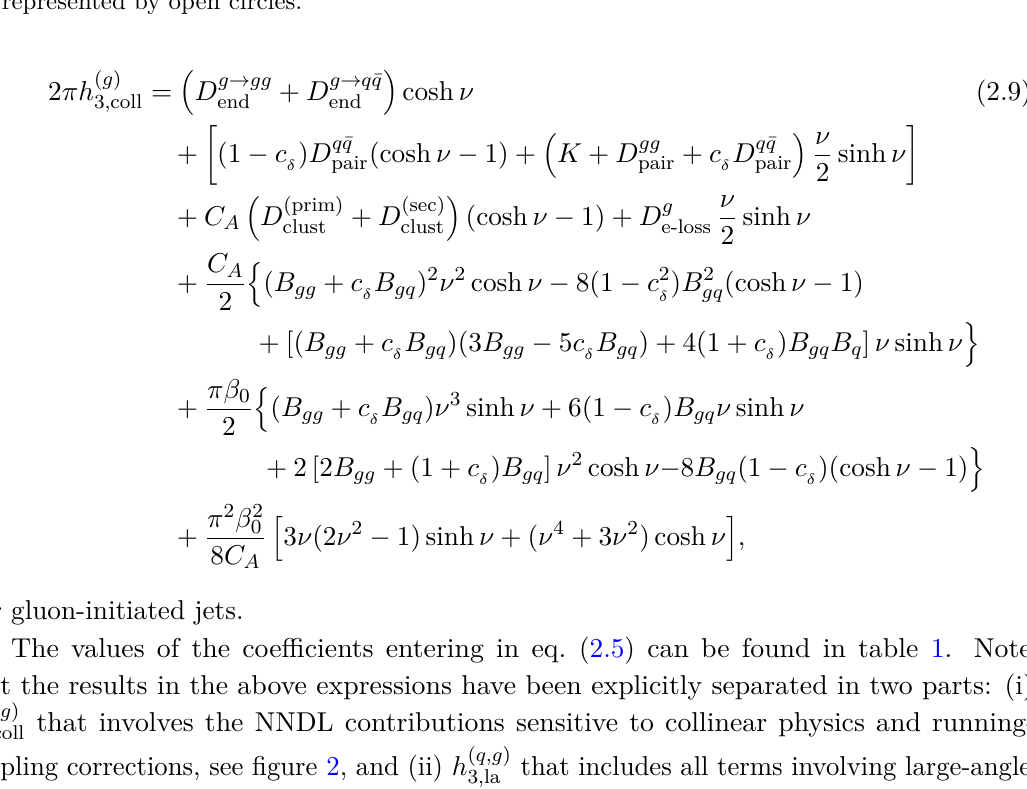
2 , blue dots emissions which s L . Running coupling corrections s